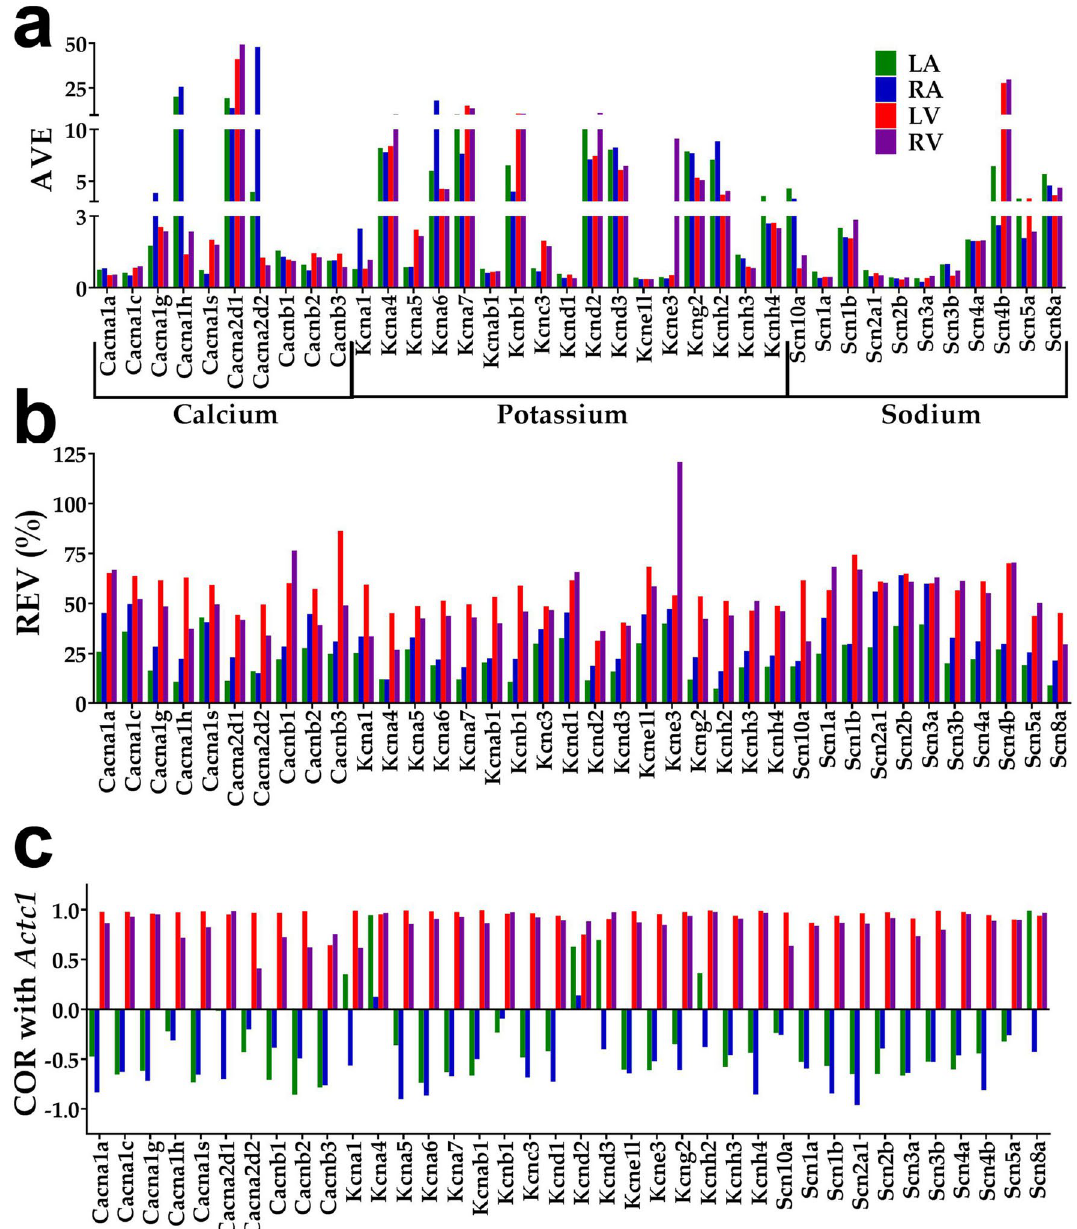
Figure 1. The three independent characteristics of voltage-dependent calcium, potassium and sodium channels in the left atrium (LA), right atrium (RA), left ventricle (LV) and right ventricle (RV). ( a ) Average expression level (AVE); ( b ) (relative) expression variation (REV); ( c ) expression correlation (COR with Actc1 ). AVE unit is the normalized median of all genes quantified in all samples, so AVE = 20 indicates that expression of Cacna1h in LA is 20 × larger than that of the median gene in all 16 samples. Expression variation is quantified by the Relative Expression Variation (REV) and expression correlation is measured by COR, the Pearson product- momentum correlation coefficient between the (log 2 ) expression levels of the two genes across the biological replicas (see